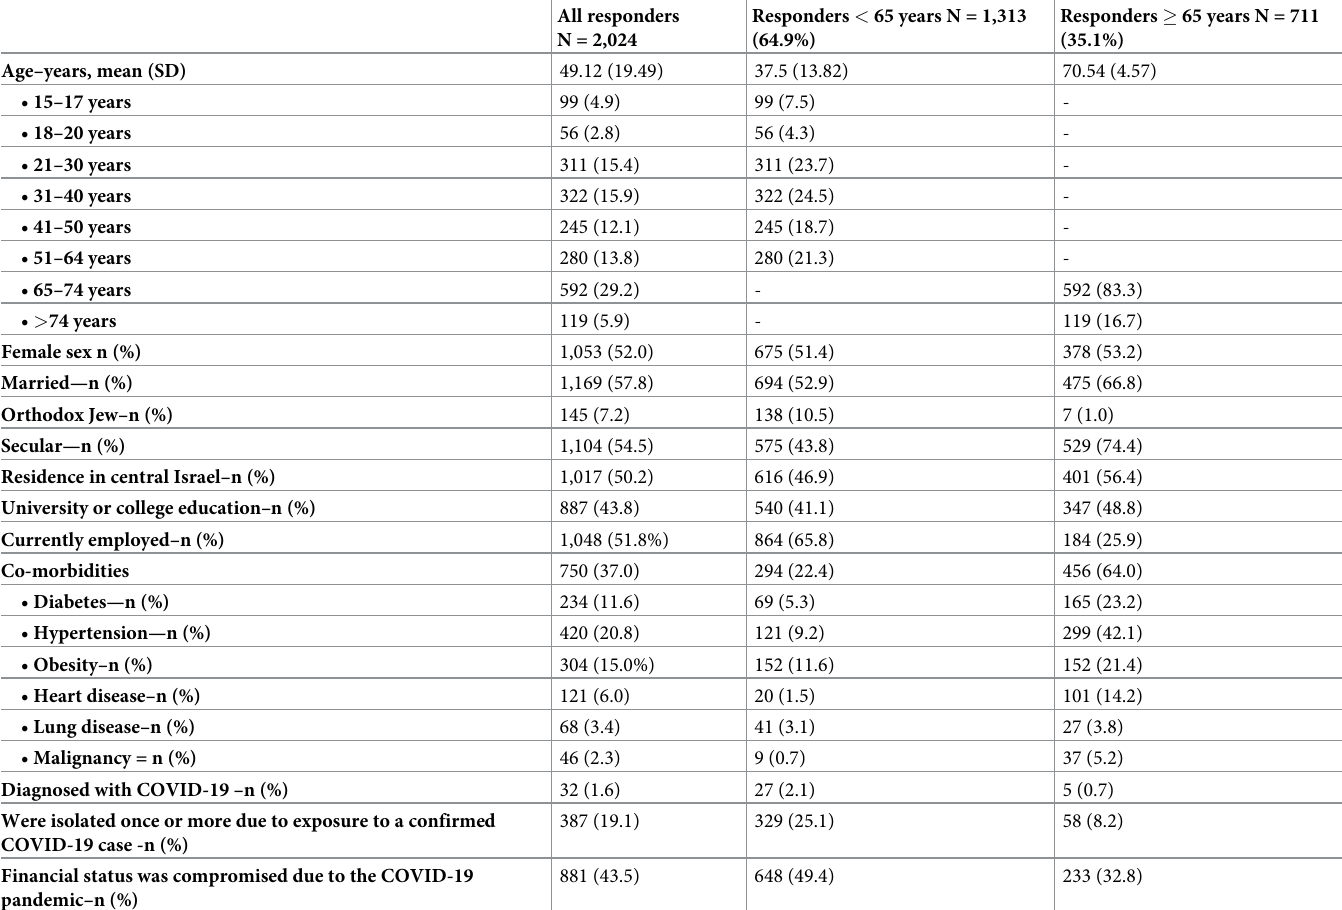
Table 1. Characteristics of people responding to the